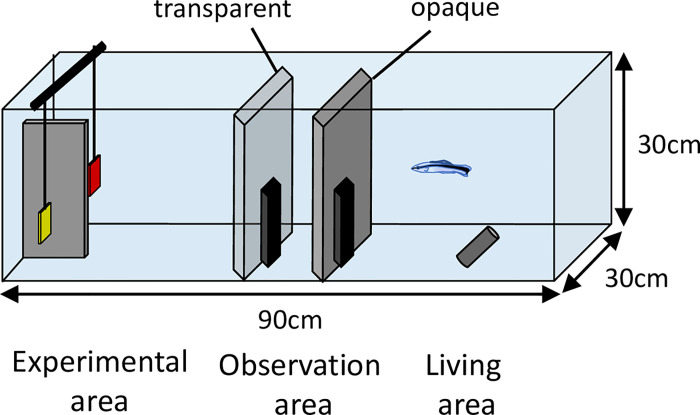
Schematic drawing of the experimental apparatus.The tank was separated by opaque and transparent partitions into three compartments (living, observation, and experimental areas). During the experiment, two plates were presented in the experimental area and separated by an opaque partition (see Methods).